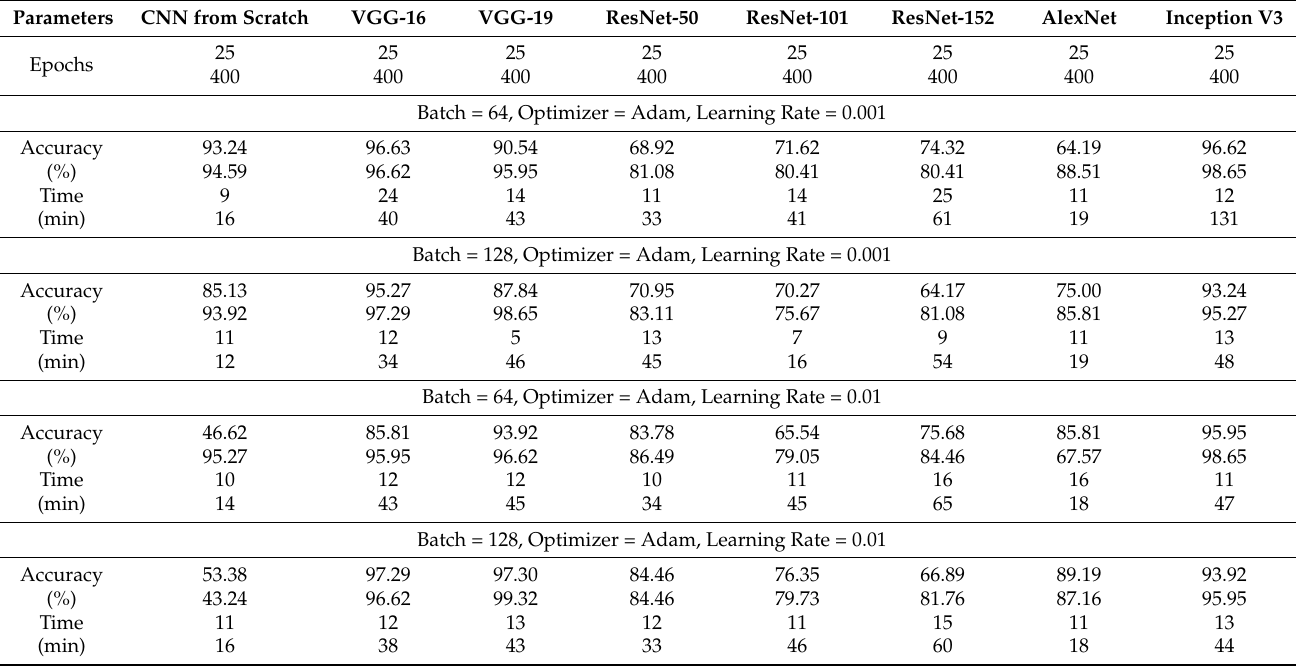
Table 2. Accuracy evaluation of eight CNN architectures, changing the values of the hyperparameters of a batch, learning rate, and epochs, using the Adaptive Moment Estimation (Adam) parameter as an optimizer. Parameters